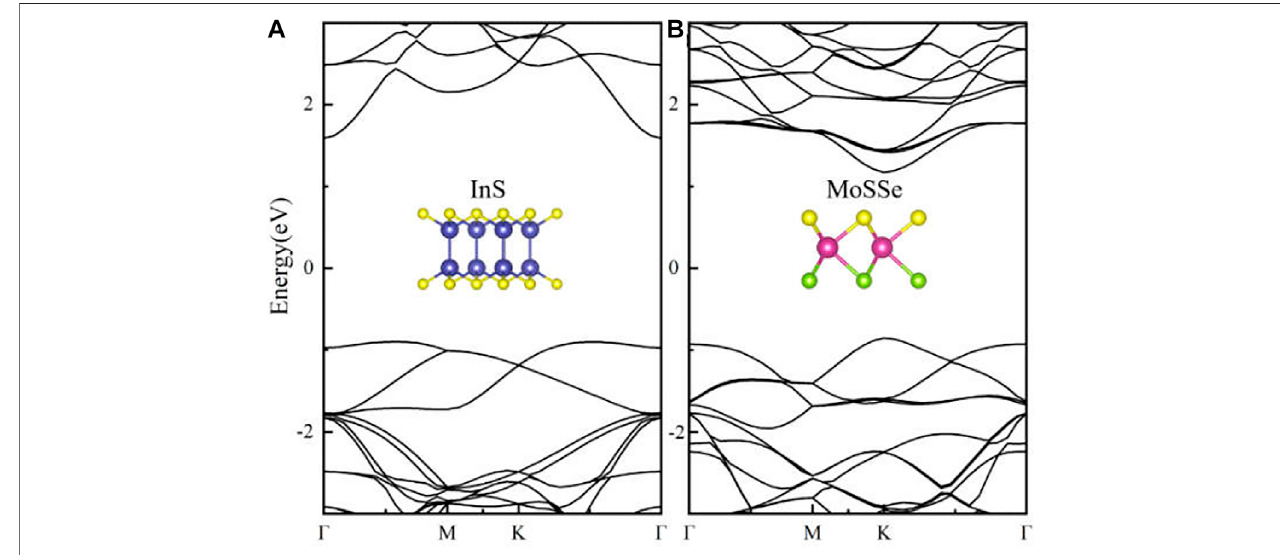
FIGURE 1 | Band structures of (A) InS and (B) MoSSe